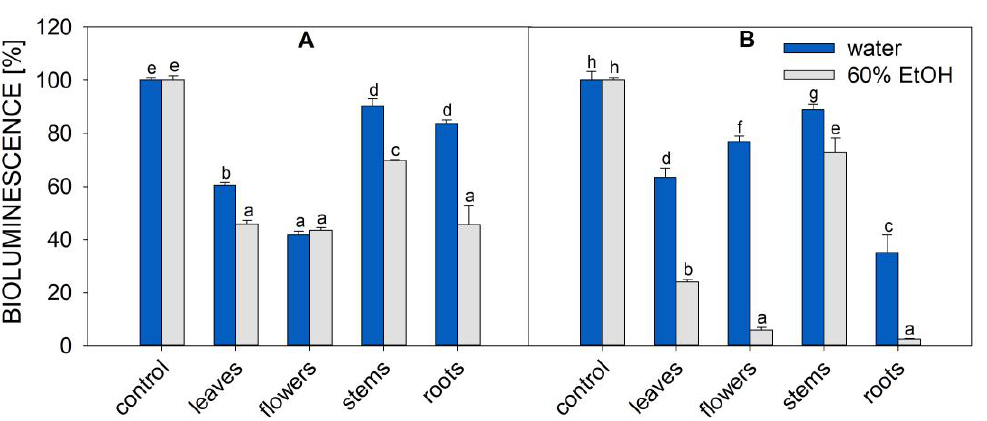
Figure 2. Bioluminescence of PA-Lux (indicating bacteria viability) in the presence of A. eupatoria ( A ) and O. vulgare ( B ) extracts prepared in water (blue columns) or 60% ethanol (grey columns). Evaporated extracts dissolved in LB medium were incubated with PA-Lux for 1 h at 37 °C. The plant extract in LB medium (100 μL) was diluted with an equal volume of PA-Lux suspension. Negative control (100%) represents the bioluminescence of PA-Lux with LB medium only. The values show the mean ± SD (n = 3 biological series). Different letters next to each bar denote significant differences ( p ≤ 0.05) among the plant groups according to ANOVA (Holm–Sidak method). Abbreviations: LB, Luria broth; PA-Lux, luminescent strain of P. aeruginosa .